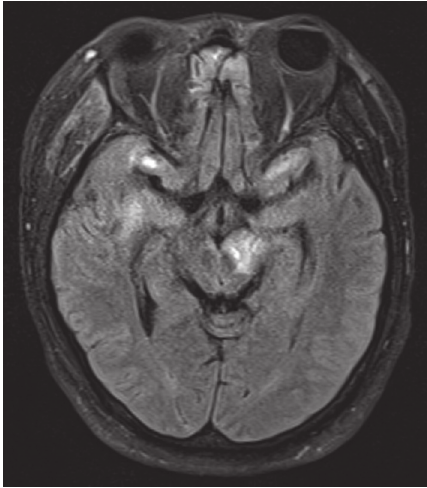
Figure 5: Axial FLAIR and sagittal T1WI MRI showing a signif- icant injury to the left midbrain and multiple intraparenchymal contusions in the frontal, temporal, and parietal lobes.